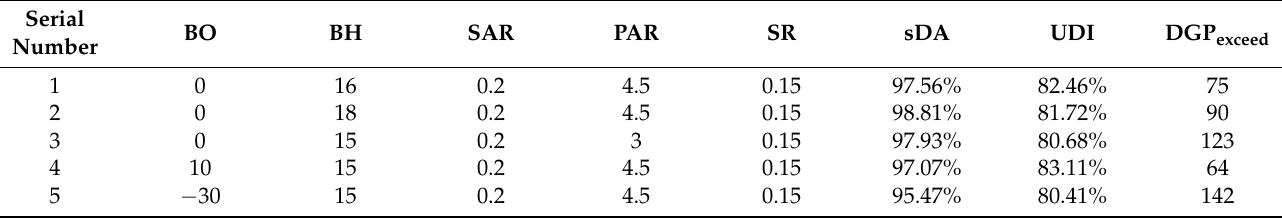
Table 2. Selected samples of the